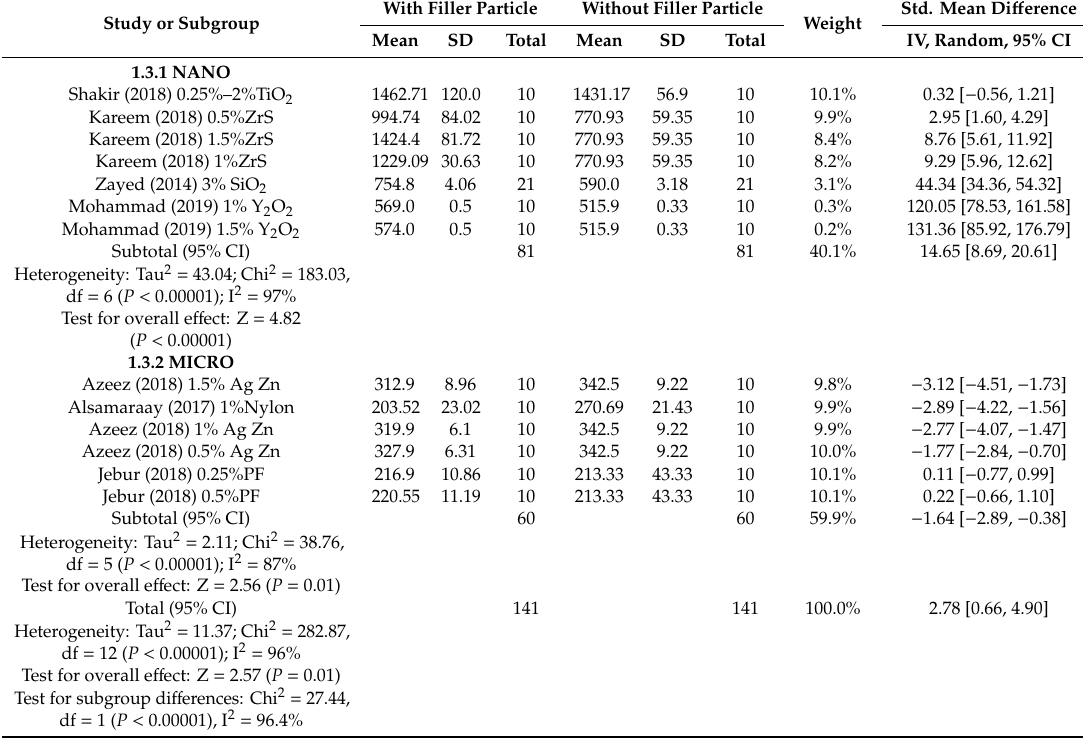
Table 10. Subgroup analysis and forest plot of elongation at break (%)